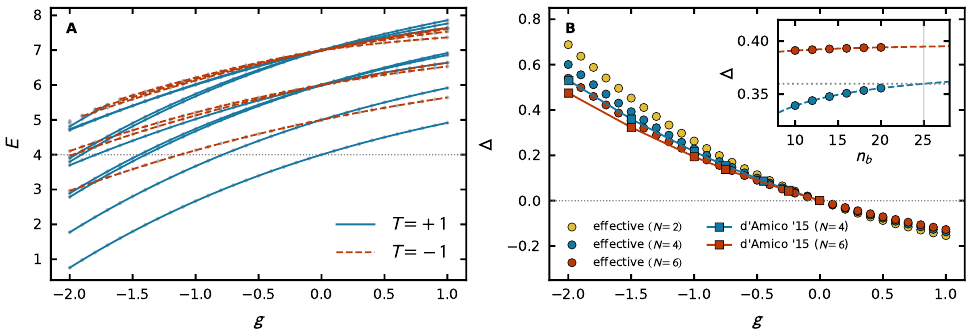
Figure 2: Spectrum and pairing gap. (A) The spectrum of the 2 ↑ + 2 ↓ system as a function of the interaction strength g . The (blue) solid curves show the states with T = 1; the (red) dashed curves show the states with T = − 1. The difference between the lowest dashed curve and the lowest solid curve is written as 2 ∆ + 1, where ∆ is the pairing gap. (B) The pairing gap as a function of the interaction strength g . We also present the data from an earlier FCI calculation with bare interaction (squares, lines are added to guide an eye) [ 25 ] . (Inset) Convergence of the gap as a function of the basis cutoff n for bare (blue symbols) and effective (red symbols) interactions b for N = 2 ↑ + 2 ↓ at g = − 1.5, including a fit to the respective data (dashed curves). = 25. Our data The horizontal dotted line is the result from [ 25 ] obtained with n b = 13, for which the error-bars are on the scale in the main plot are obtained with n b of the corresponding